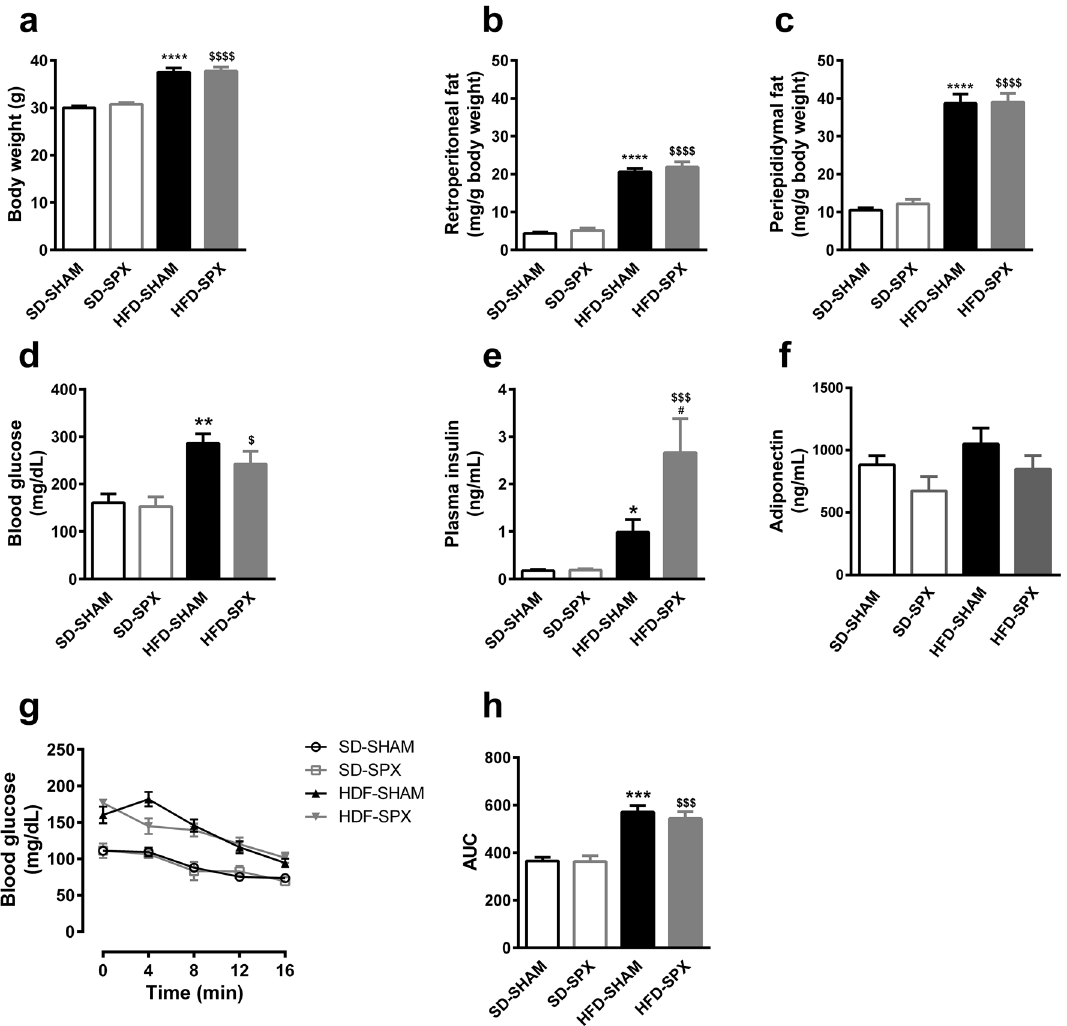
Figure 1. High-fat diet (HFD) increased adiposity and impaired glucose homeostasis in the presence and absence of the spleen. ( a ) Final body weight, ( b ) retroperitoneal and ( c ) periepididymal fat mass, ( d ) blood glucose, ( e ) plasma insulin and ( f ) plasma adiponectin levels, ( g ) blood glucose levels and area under the curve (AUC) during insulin tolerance test (ITT) in sham-operated (SHAM) or splenectomized (SPX) mice fed with standard diet (SD) or HFD. (n = 32 to 33 per group and n = 5 to 8 per group for blood glucose, insulin and adiponectin levels and ITT). Data were expressed as mean ± SEM. ANOVA: ** P < 0.01 and **** P < 0.0001, HFD- SHAM versus SD-SHAM; $$$ P < 0.001 and $$$$ P < 0.0001, HFD-SPX versus